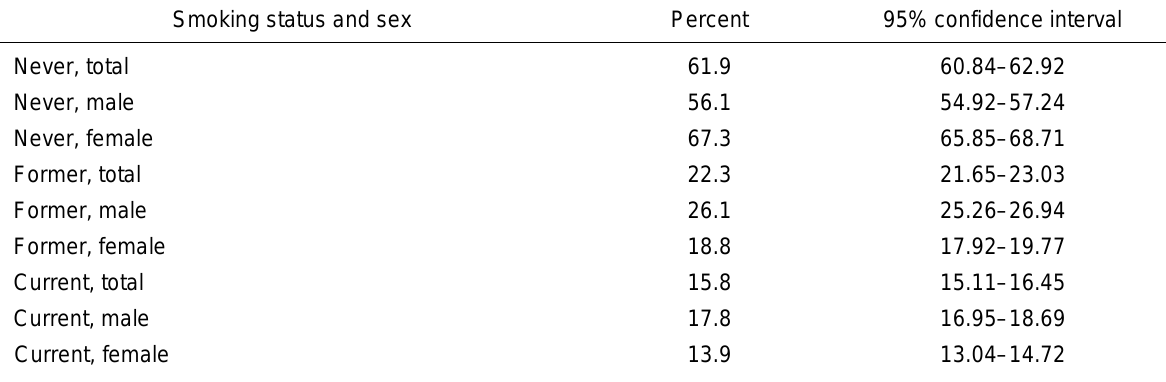
Data table for Figure 8.2. Percent distribution of cigarette smoking status among adults aged 18 and over, by sex: United States, 2016